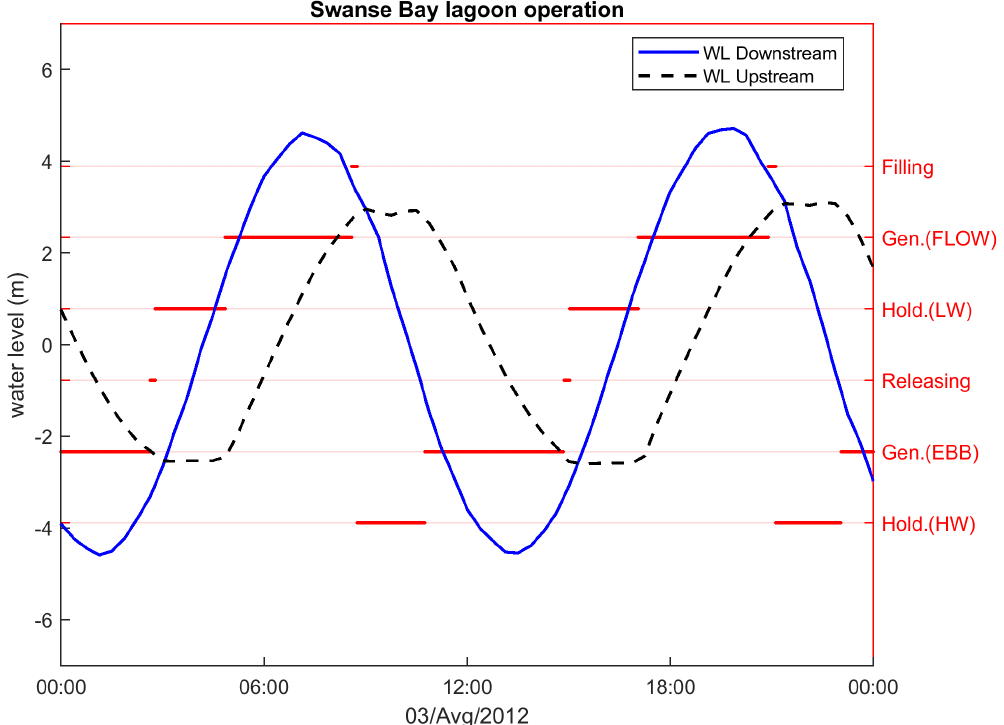
Figure 8. Two-way generation sequence represented by water elevation on either side of the lagoon.